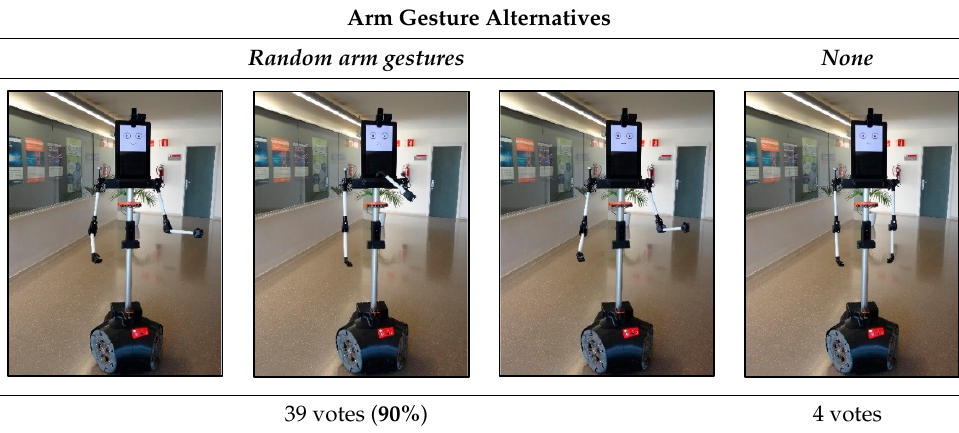
Algorithm 1. Pseudo-code used to animate the arms.